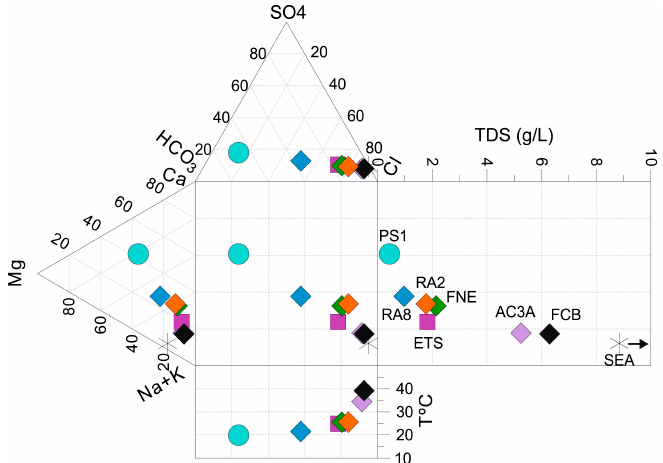
Figure 3. Durov diagram showing major ions concentrations, water temperature (T) and total dis- solved solids (TDS) of sampled waters. SEA: seawater composition from [49]. The strong correlation between Na + and Cl − ions also suggests that these two elements have the same origin. However, water samples show a wide range of the Na + /Cl − (molar) ratio (between 0.80 and 1.35), even larger than two possible sources of both elements, as typical seawater (0.86) and halite dissolution (1.00) (Table 1). Considering the water samples analyzed in the present study as different degrees of sea- water–freshwater mixtures, the percentage of seawater in each water sample was calculated (Table 1) using the following equation: (cid:3435)𝐶 (cid:4666)(cid:3040)(cid:4667) − 𝐶 (cid:4666)(cid:2868)(cid:4667) (cid:3439) 𝑋 = (cid:4680) (cid:3439)(cid:4681)100 (1) (cid:3435)𝐶 (cid:4666)(cid:3046)(cid:3032)(cid:3028)(cid:4667) − 𝐶 (cid:4666)(cid:2868)(cid:4667) where X stands for the percentage of seawater in the mixture, C ( m ), C ( 0) and C ( sea ) the con- centration of a marine element as chloride in the mixture (water sample), the freshwater (considering the regional PS1 water sample), and the seawater, respectively. The percent- ages of seawater obtained for each water sample using the dissolved chloride concentra- tion in Equation (1) are in Table 1. As expected, the highest seawater percentage was ob- tained for the AC3A and FCB water samples, but less than 20% in any case. Additionally, the Cl/Br (molar) ratio could be a useful natural tracer of the saliniza- tion origin, discriminating specifically between evaporate and marine Cl sources [54]. For a better understanding, composition fields of potential salinization sources in a similar environment have been also plotted in Figure 4. The Cl/Br (molar) ratios and Cl − concen- trations in water samples show again typical values from progressive seawater-fresh wa- ter mixing trend, where the warmer and saline FCB and AC3A samples and the colder and fresh RA8 sample (Br data are not available for PS1 sample) are close to seawater intrusion and recharge waters fields, respectively. RA2, FNE, and ETS water samples, with similar Cl/Br ratios and Cl − concentrations, have been plotted in an intermediate po- sition, but also close to the water affected by anthropogenic and urban effects, represented by the “Leaching of solid waste” field.